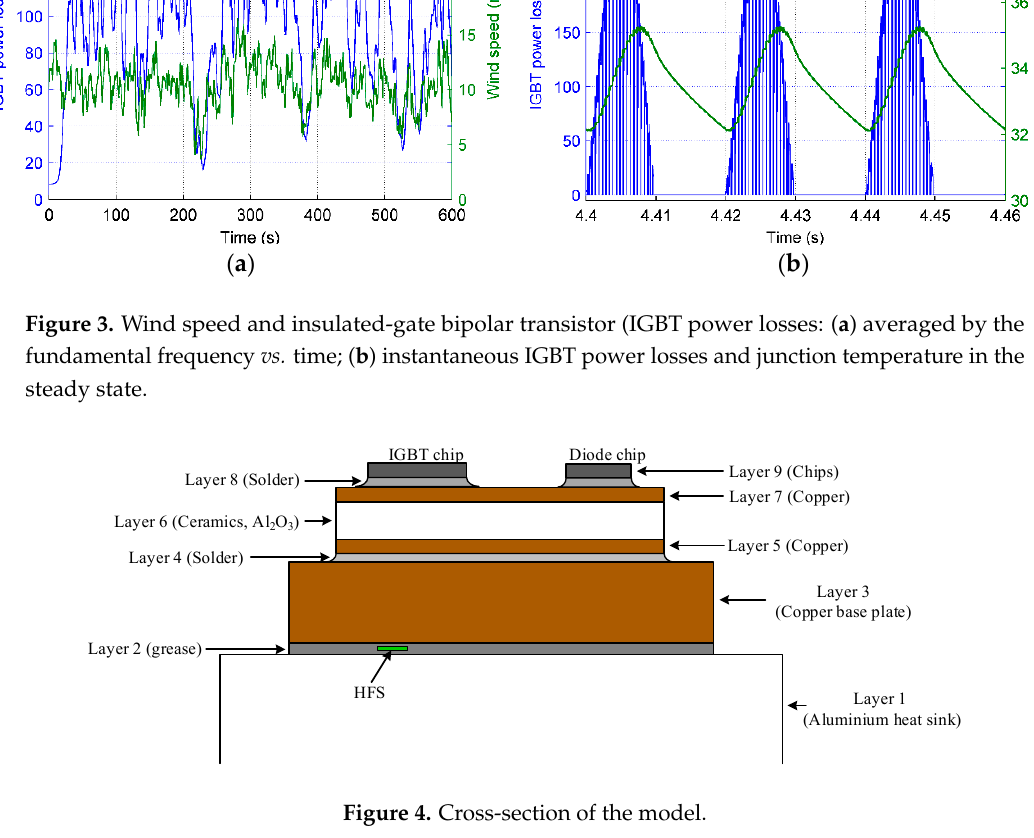
Figure 3. Wind speed and insulated ‐ gate bipolar transistor (IGBT power losses: ( a ) averaged by the fundamental frequency vs. time; ( b ) instantaneous IGBT power losses and junction temperature in the steady state. Table 1. Properties of the materials in the model.